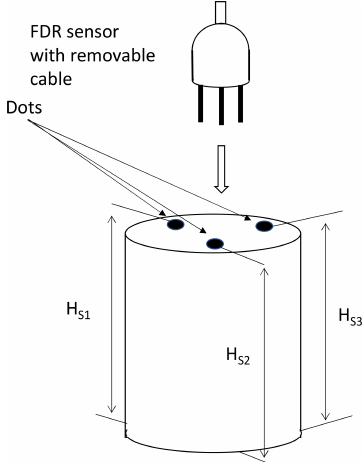
Figure A1. Calibration